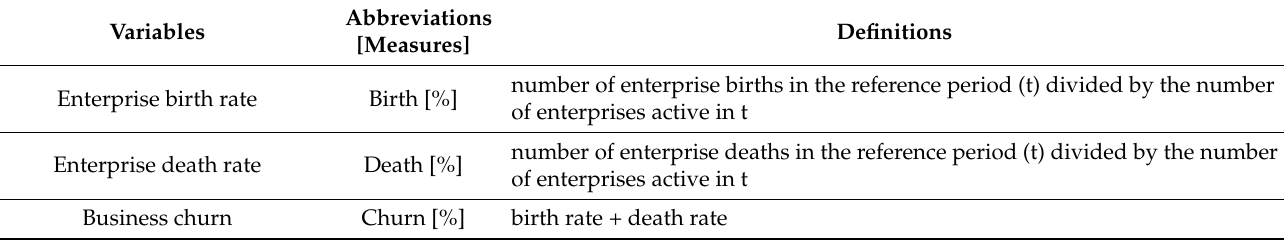
Table 1. Description of the independent